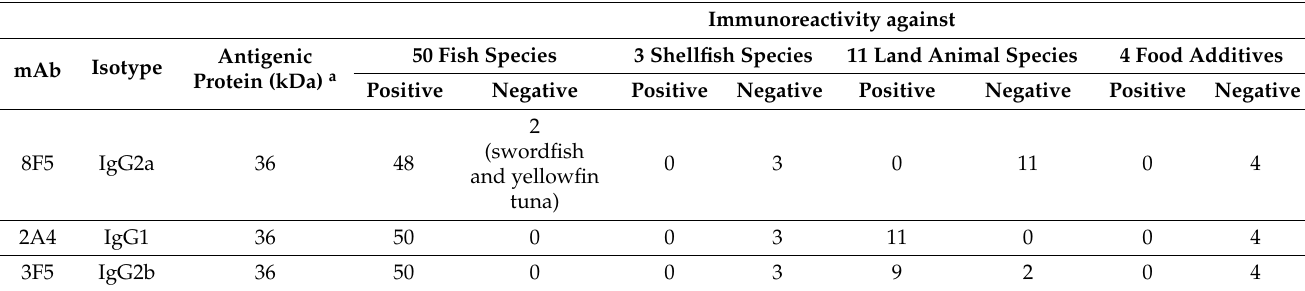
Table 2. Isotypes, antigenic proteins, and summarized iELISA results against 50 species of fish, three shellfish, 11 land animals, and four food additives of the three anti-fish